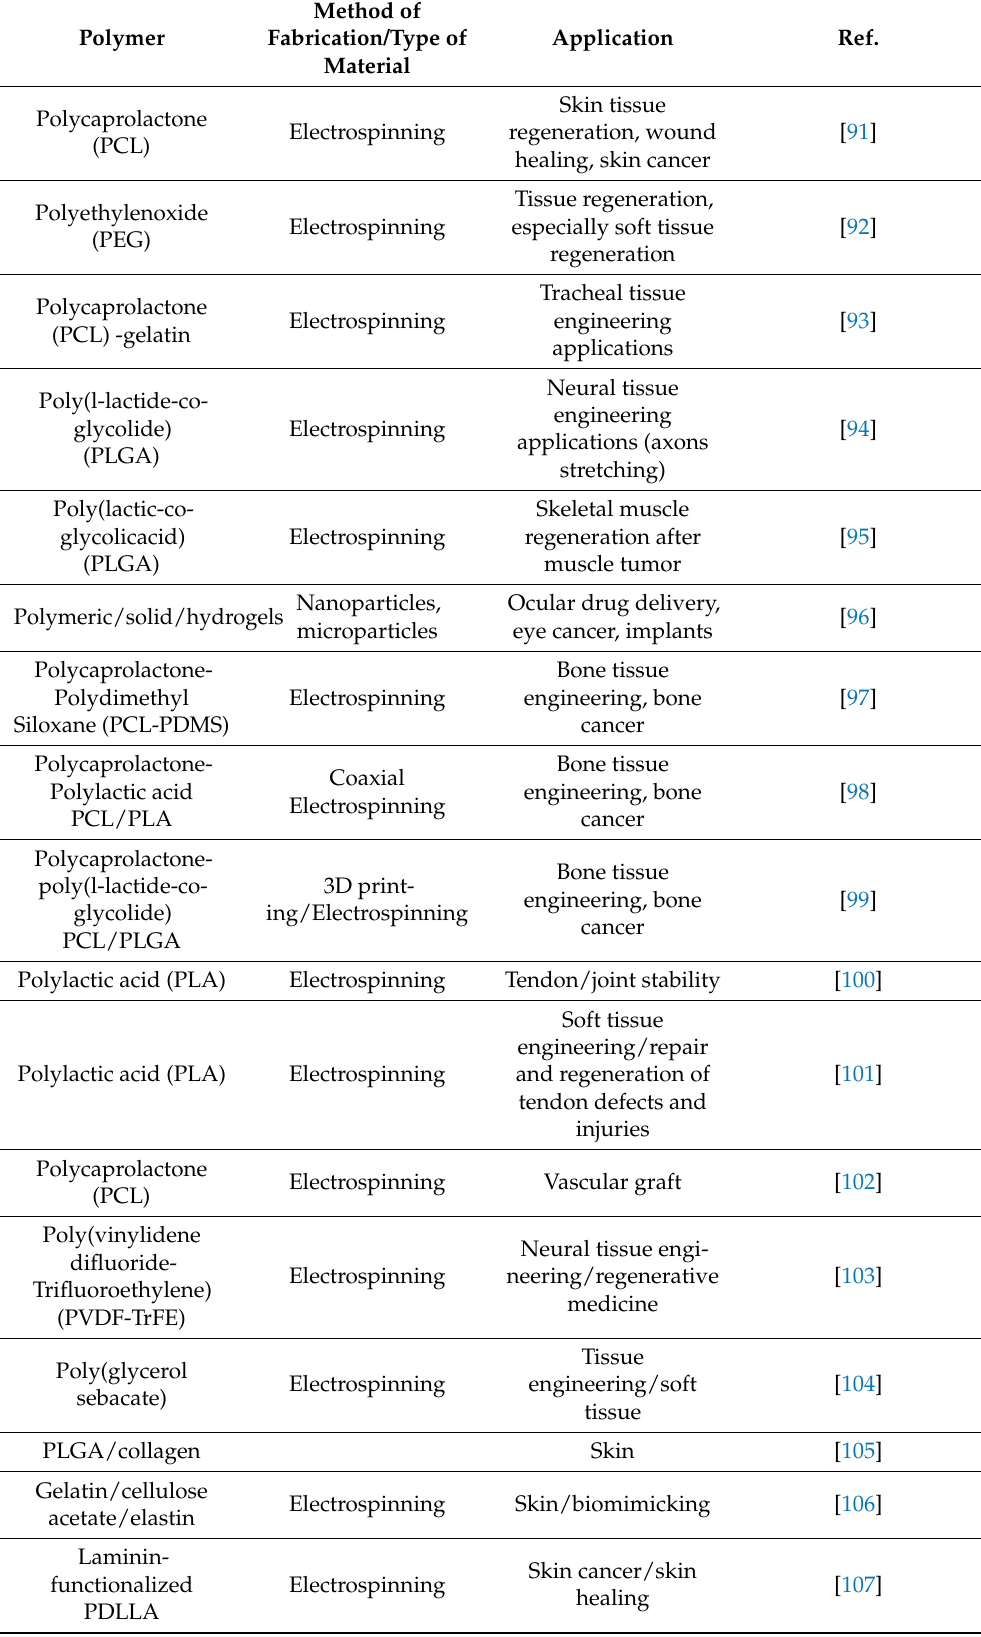
Table 1. Overview of degradable and non-degradable polymers and their biomedical applications in cancer treatment and regenerative